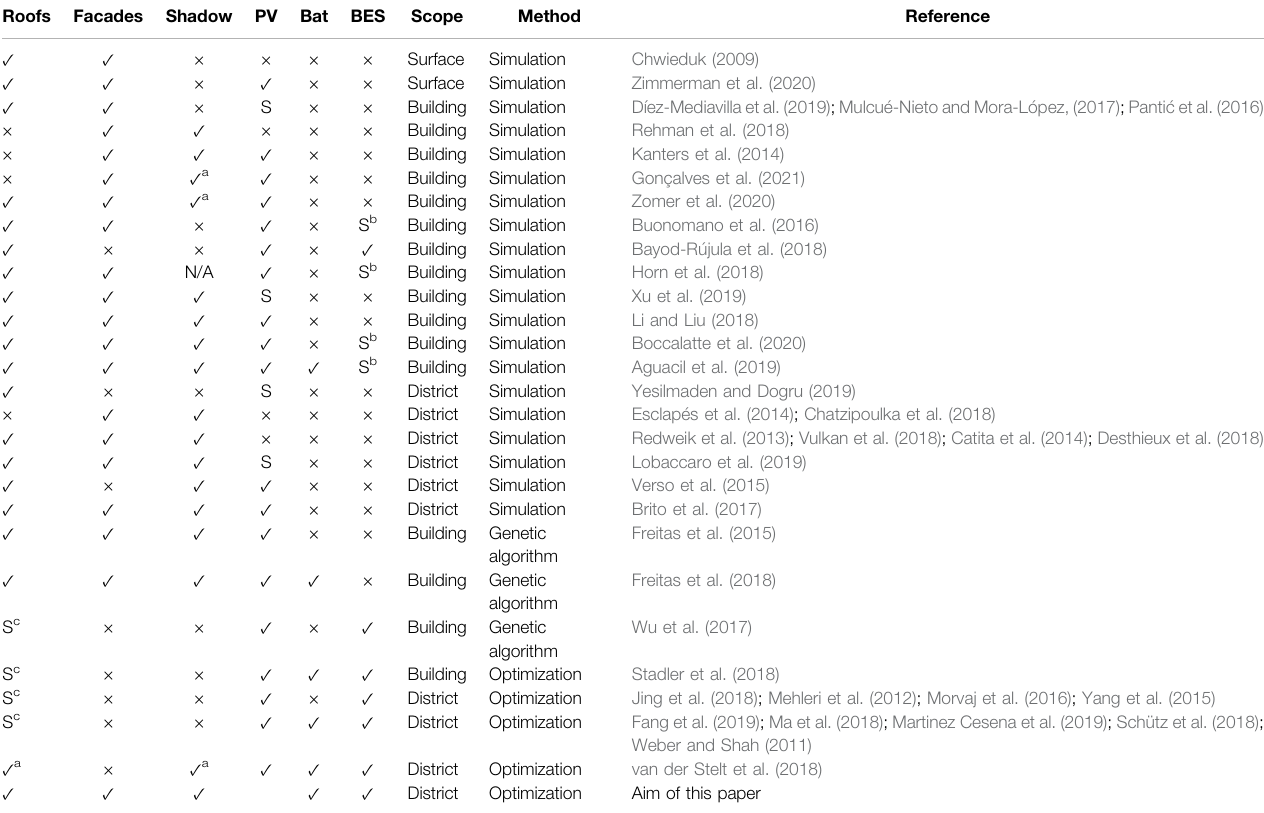
TABLE 1 | Literature overview. ✓ (cid:1) yes, aspect included, × (cid:1) no, not included, S (cid:1) simpli fi ed, N/A (cid:1) not answered, PV (cid:1) photovoltaic panels, BAT (cid:1) battery, and BES (cid:1) building energy system. Roofs Facades Shadow PV Bat